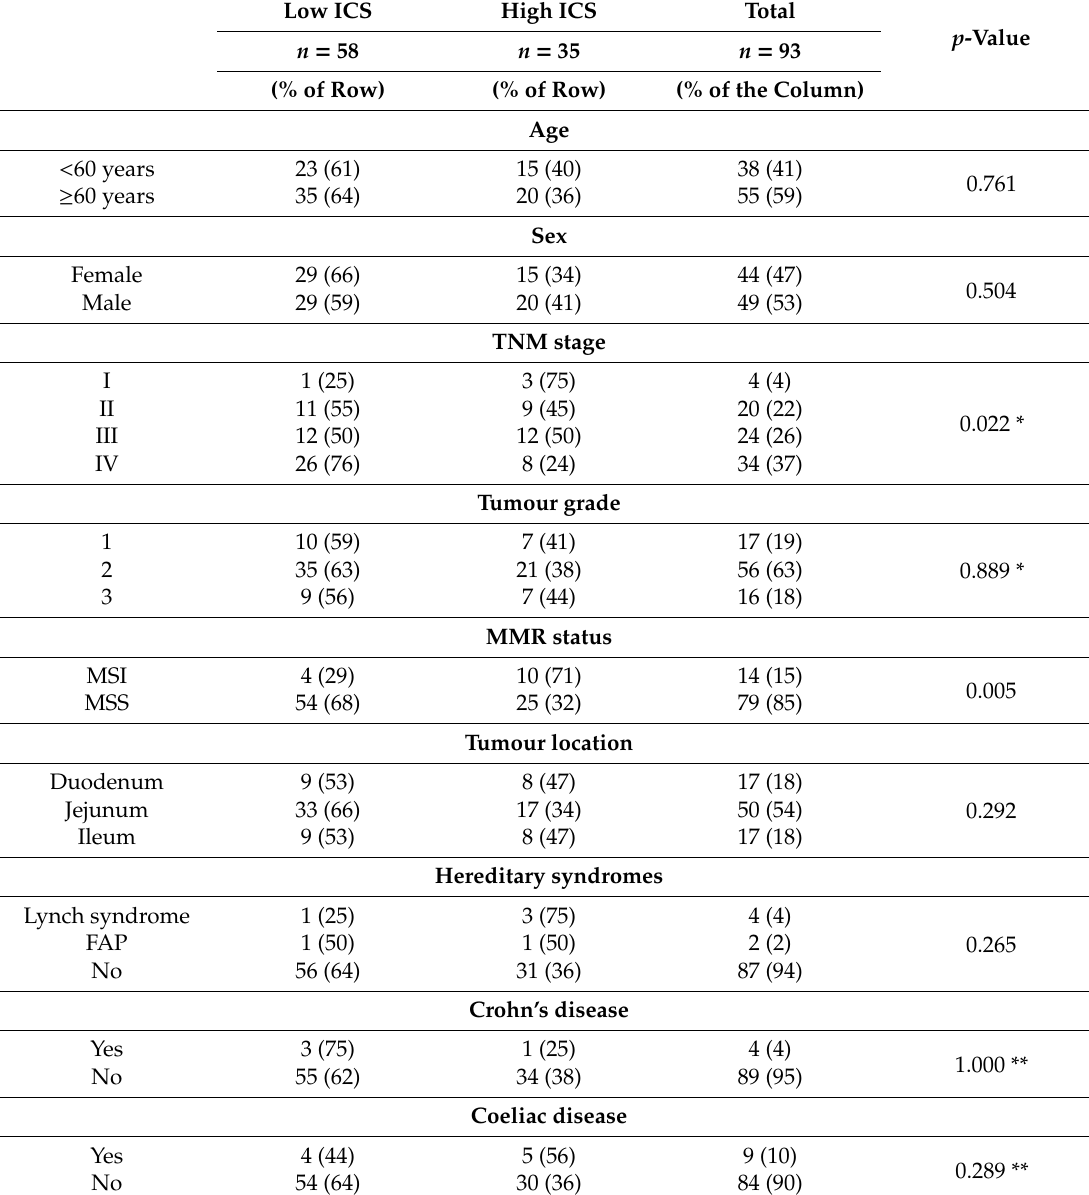
Table 1. Clinicopathological variables and their associations with Immune cell